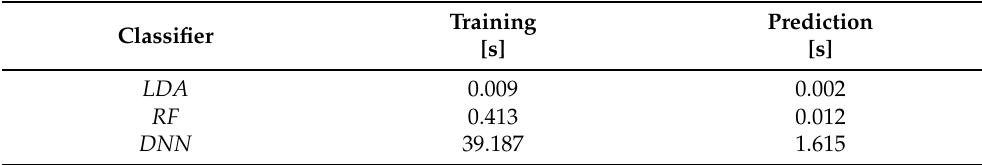
Table 4. Times of classifier training and prediction for N c = 24 PCA feature